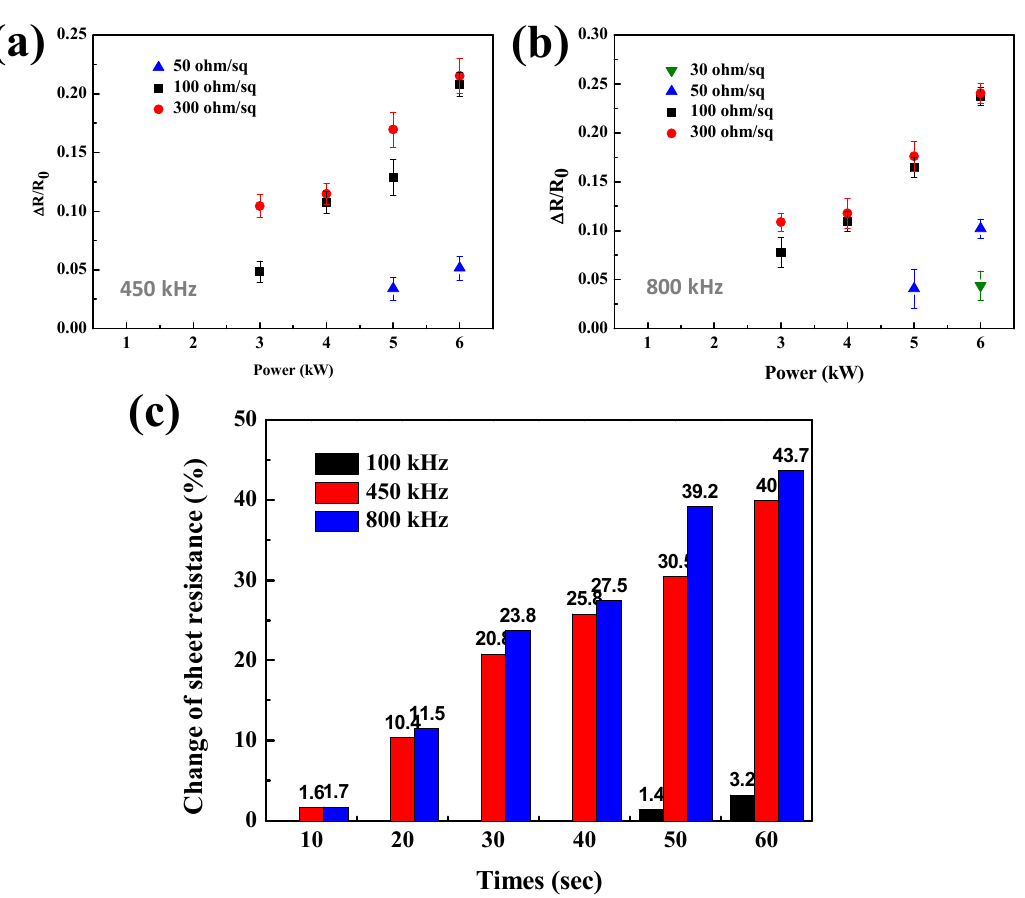
Figure 3. Sheet resistance change according to the inductive heating of the Ag NW network for 30 s at ( a ) 450 and ( b ) 800 kHz. ( c ) Comparison of sheet resistance change over induction heating time with 6 kW power applied to each frequency for 100 ohm/sq of initial resistance Ag NW-coated thin films.